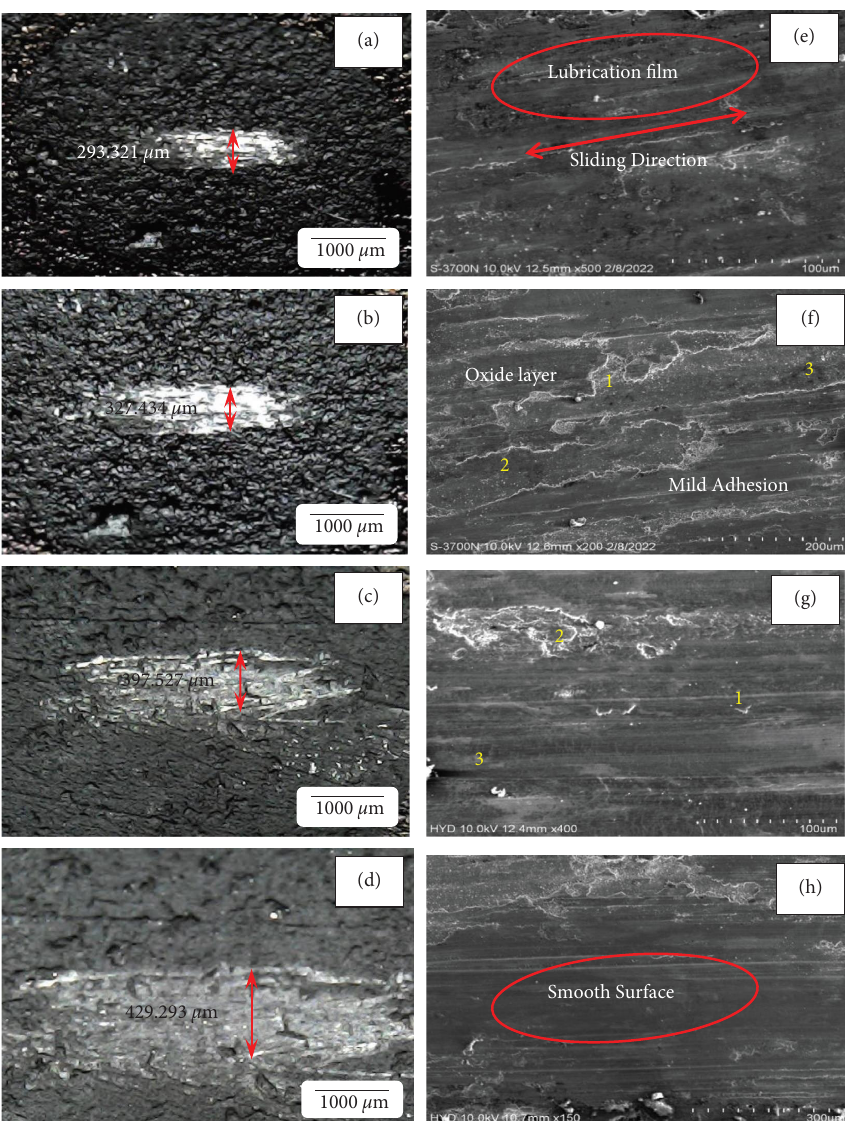
Figure 12: Micrographs of HAlSi24 under lubricated condition at (a) 20 N, (b) 30N, (c) 40N, and (d) 50 N. Morphology of HAlSi24 under lubricated conditions at (e) 20N, (f) 30 N, (g) 40N, and (h)